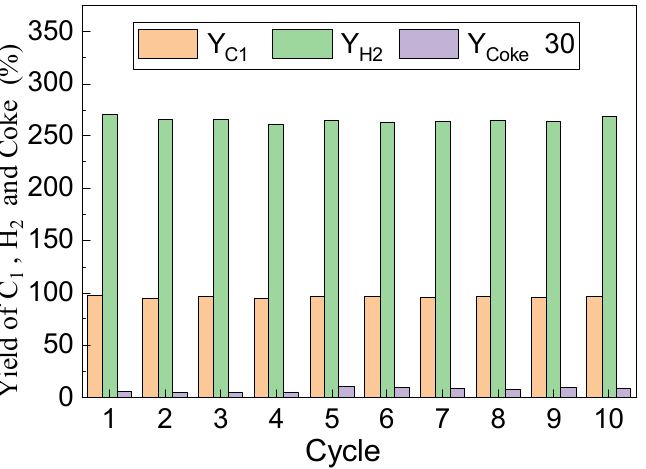
Figure 14. Yield of C 1 , H 2 , and coke (  30) during chemical looping toluene conversion using LaFe 0.6 Ni 0.4 with S/C = 1.6 at 900 °C. LaFe ◦ 0.6 Ni 0.4 with S/C = 1.6 at 900